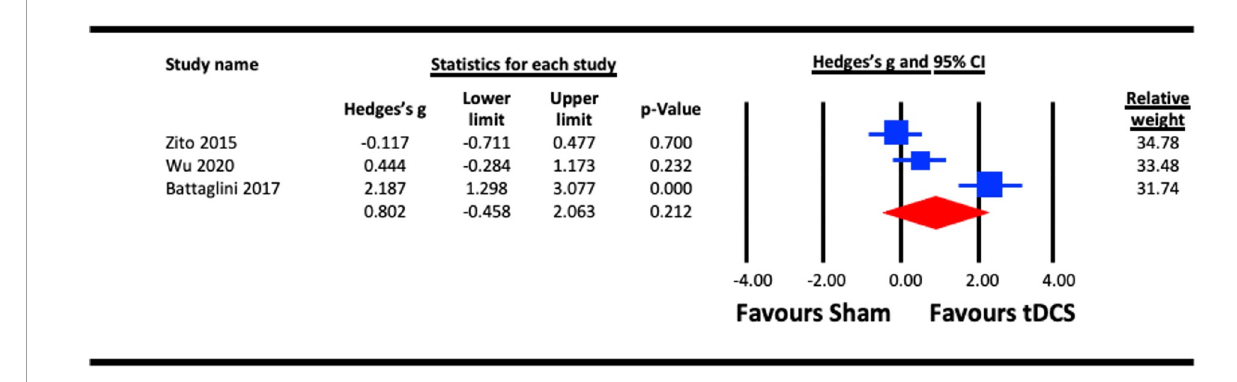
FIGURE9 Acute effect of anodal-transcranial direct current stimulation (a-tDCS) on motion perception.